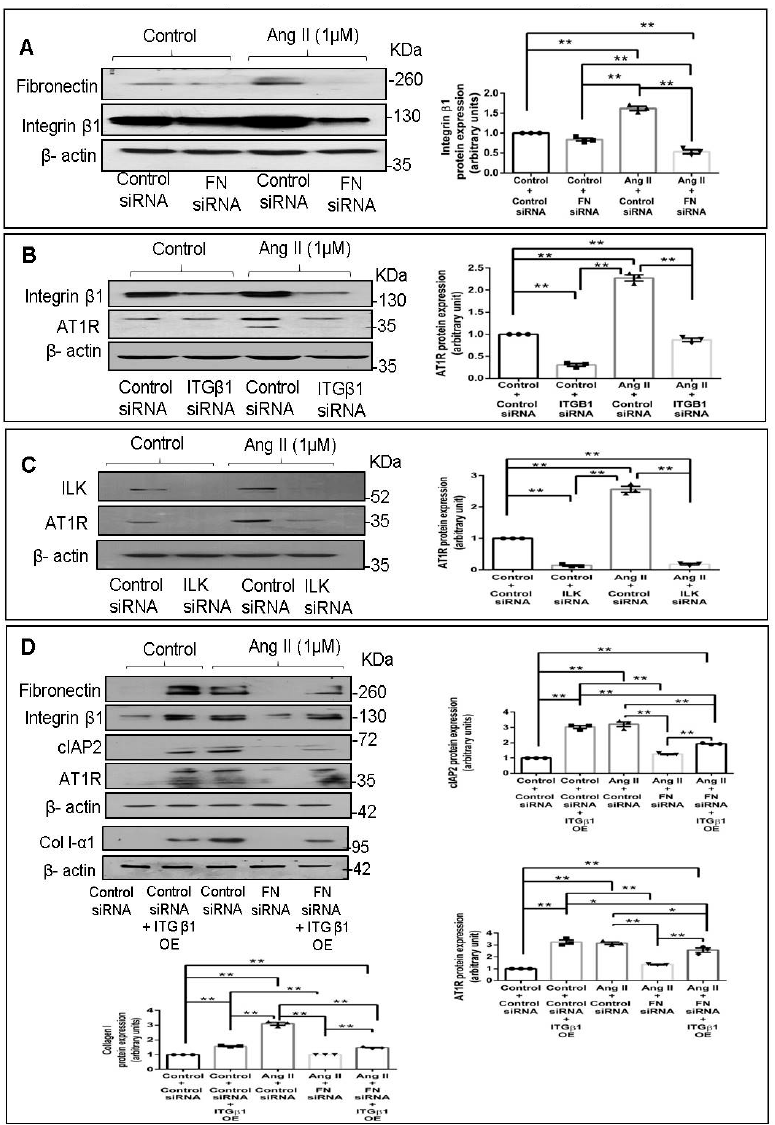
Figure 4. Fibronectin regulates Ang II-stimulated AT1R protein expression through Integrin β 1/Integrin-linked kinase signaling pathway. ( A ) Cardiac fibroblasts were transiently transfected with fibronectin siRNA (20 pmol) or control (scrambled) siRNA prior to treatment with Ang II for 12 h. Integrin- β 1 (ITGB1) protein expression was examined with β -actin as loading control. ** p < 0.01 (comparisons as depicted in the figure). ( B ) Cardiac fibroblasts were transiently transfected with ITGB1 siRNA (5 pmol) or control (scrambled) siRNA prior to treatment with Ang II for 12 h. AT1R protein expression was examined, with β -actin as loading control. Validation of Integrin- β 1 silencing is also shown. ** p < 0.01 (comparisons as depicted in the Figure). ( C ) Cardiac fibroblasts were transiently transfected with ILK siRNA (5 pmol) or control (scrambled) siRNA prior to treatment with Ang II for 12 h. AT1R protein expression was examined, with β -actin as loading control. ** p < 0.01 (comparisons as depicted in the Figure). ( D ) Cardiac fibroblasts were co-transfected with fibronectin siRNA (10 pmol) and ITGB1 cDNA overexpression plasmid (2 µg). Following transfection, the cells were revived in M199 with 10% serum for 12 h. Post-revival, the cells were serum-deprived for 24 h prior to treatment with Ang II for 12 h. Cells were collected and protein levels of AT1R, cIAP2, and collagen type 1 were examined, with β -actin as loading control. * p < 0.05 and ** p < 0.01 (comparisons as depicted in the Figure). Validation of fibronectin knockdown and ITGB1 overexpression is also shown. Data are representative of three independent experiments, n = 3, Mean ± SEM.